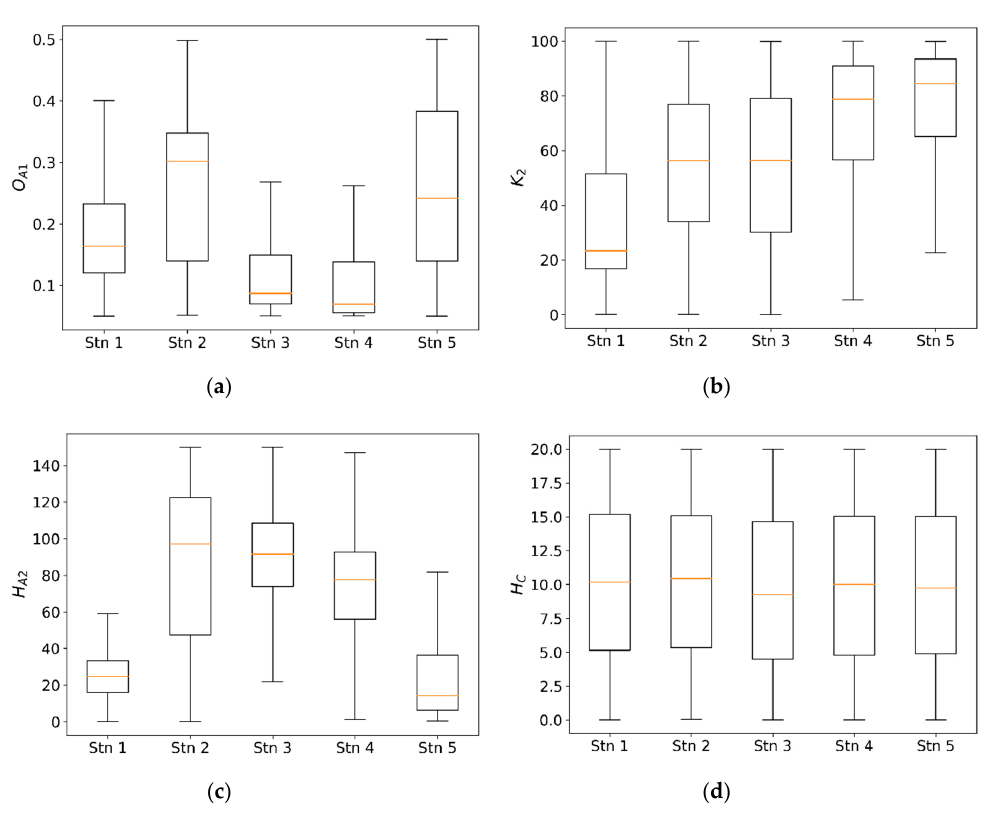
Figure 7. DREAM derived ranges of the four selected parameters across the five calibration stations (( a ) O A 1 , ( b ) K 2 , ( c ) H A 2 and ( d ) H C